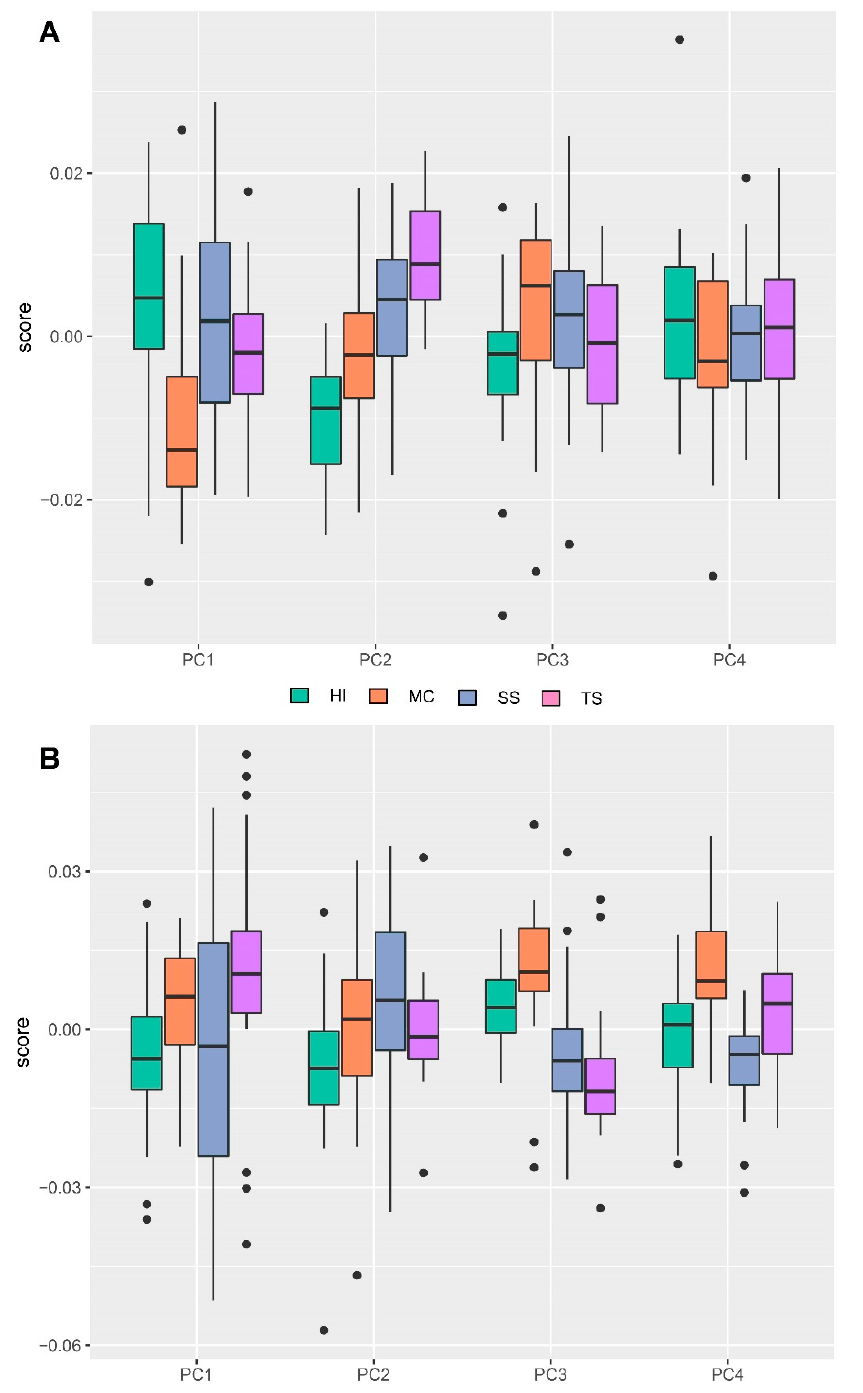
Figure 5. Box Plot of PCA scores for different populations of T. infestans . ( A ) Head view; ( B ) wing view. Green: Huacaya/Imbochi (HI); orange: Monteagudo/Cañon Largo (MC); blue: Sucre/Surima (SS), and purple: Tarabuco/Sarufaya (TS).